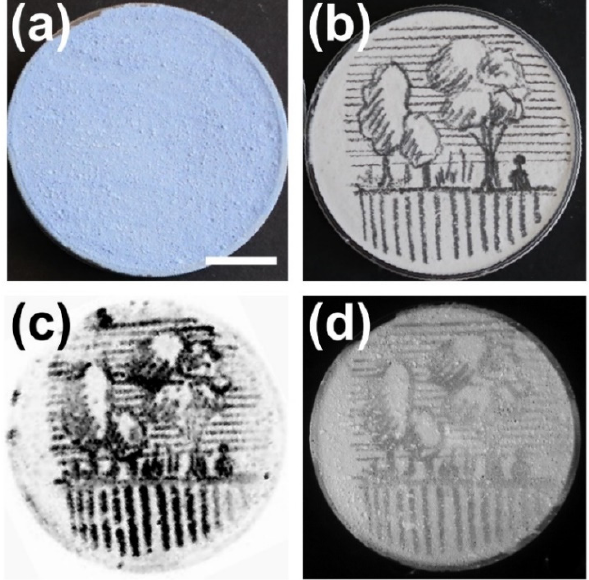
Figure 2. Images ( a ) of a mock-up covered with a paint layer containing a mixture of titanium white, gypsum, and ultramarine blue pigments, ( b ) of an underlying pencil sketch prior to the application of the paint; ( c ) maximum amplitude projection (MAP) PA reconstruction of the hidden underdrawing; ( d ) respective near-infrared (NIR) image recorded at 1100 nm. Scale bar corresponds to 1 cm.